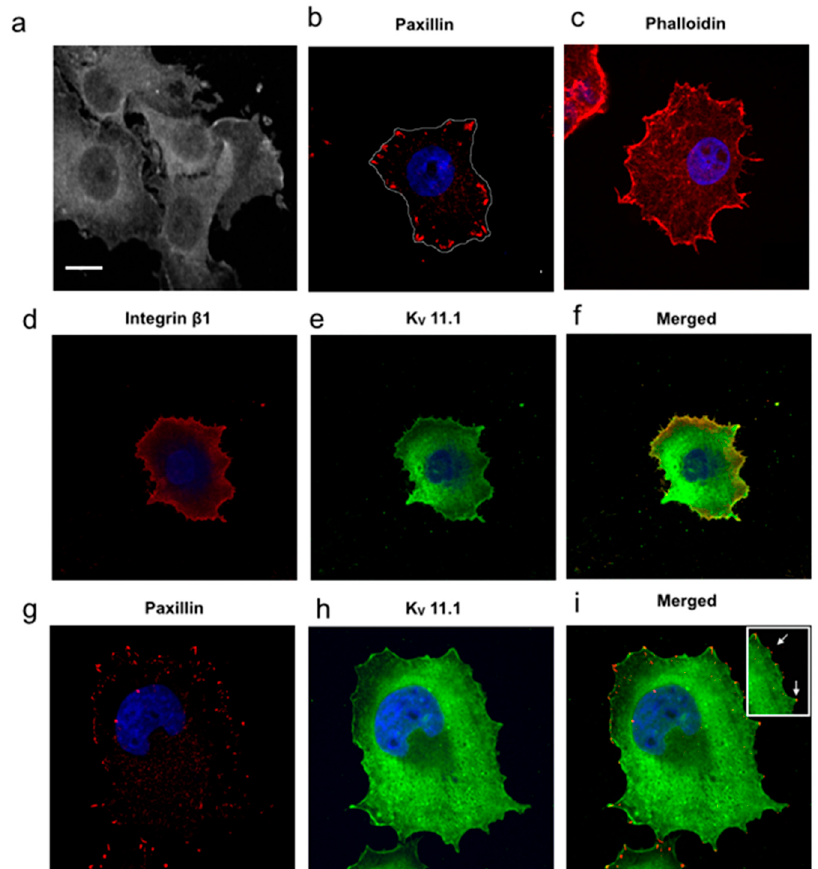
Figure 1. Phalloidin staining, K V 11.1, β 1 integrin and paxillin expression in PANC-1, Pancreatic Ductal Adenocarcinoma cells cultured onto fibronectin (FN). ( a ) Representative confocal image of spread and adherent PANC-1 cells. Scale bar: 10 µ m. Scale bar is the same for all the subpictures. ( b ) Representative confocal single cell image of fixed PANC-1 cells stained with anti-paxillin primary antibody and revealed with AF546-conjugated anti-mouse secondary antibody. Nuclei are Hoechst stained in blue. ( c ) Representative single cell image of fixed PANC-1 cells. Actin staining by Rhodamine-conjugated phalloidin (red). ( d – f ) Co-localization of K V 11.1 and β 1 integrin. Cells were stained for β 1 integrin with ts2/16 primary antibody and revealed with AF546-conjugated anti-mouse secondary antibody; for K V 11.1, anti-hERG1 mAb-AF488 conjugated antibody. Co-localization of K V 11.1 and β 1 integrin is reported (Merged, third panel from the left). ( g – i ) Co-localization of K V 11.1 and paxillin. Cells were stained with anti-paxillin primary antibody and revealed with AF546-conjugated anti-mouse secondary antibody ( g ); for K V 11.1, cells were stained using anti-hERG1 mAb-AF488 conjugated antibody ( h ). Merged image ( i ) shows that co-localization of Paxillin and K V 11.1 mainly occurs, as better evident in the inset with a higher magnification (scale bar missing for inset) showing the overlay of K V 11.1 and paxillin